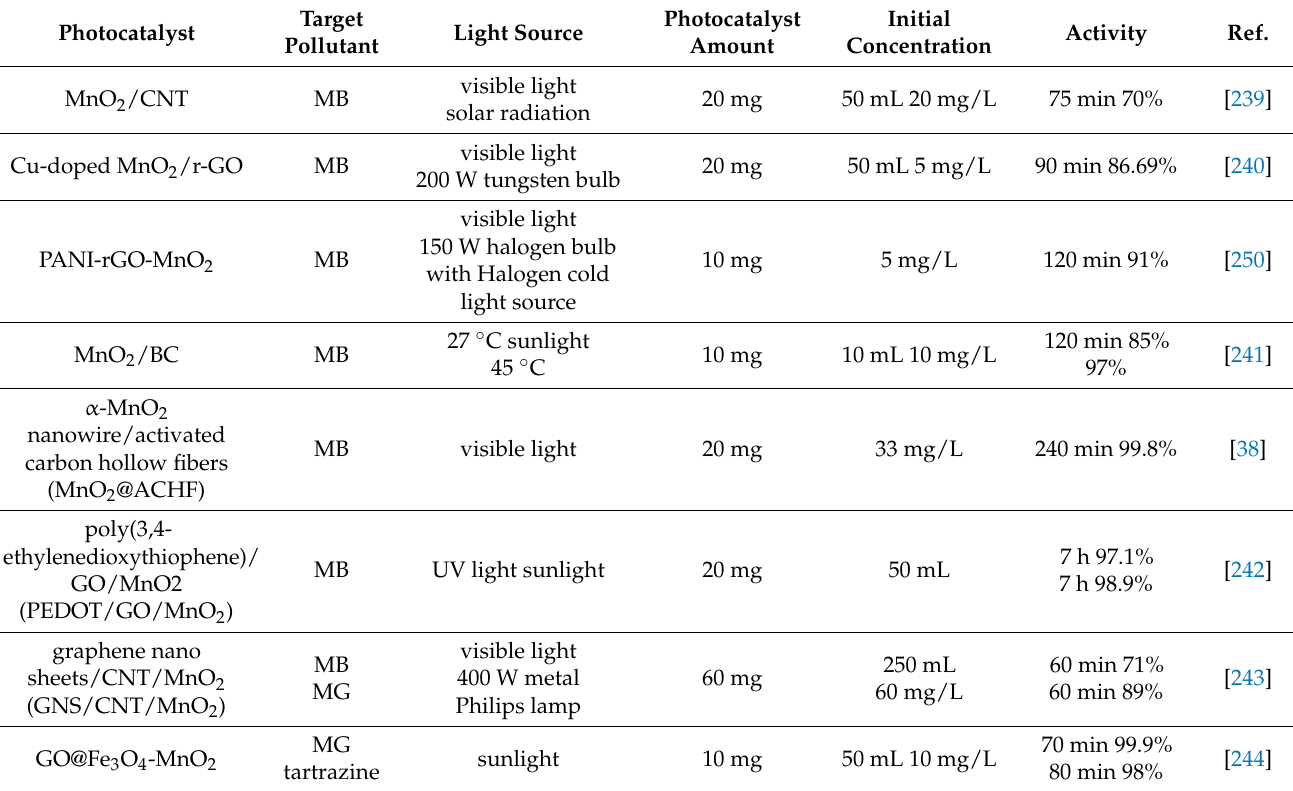
Table 4. Study on MnO 2 -carbon materials for photocatalytic degradation of organic dye in aqueous